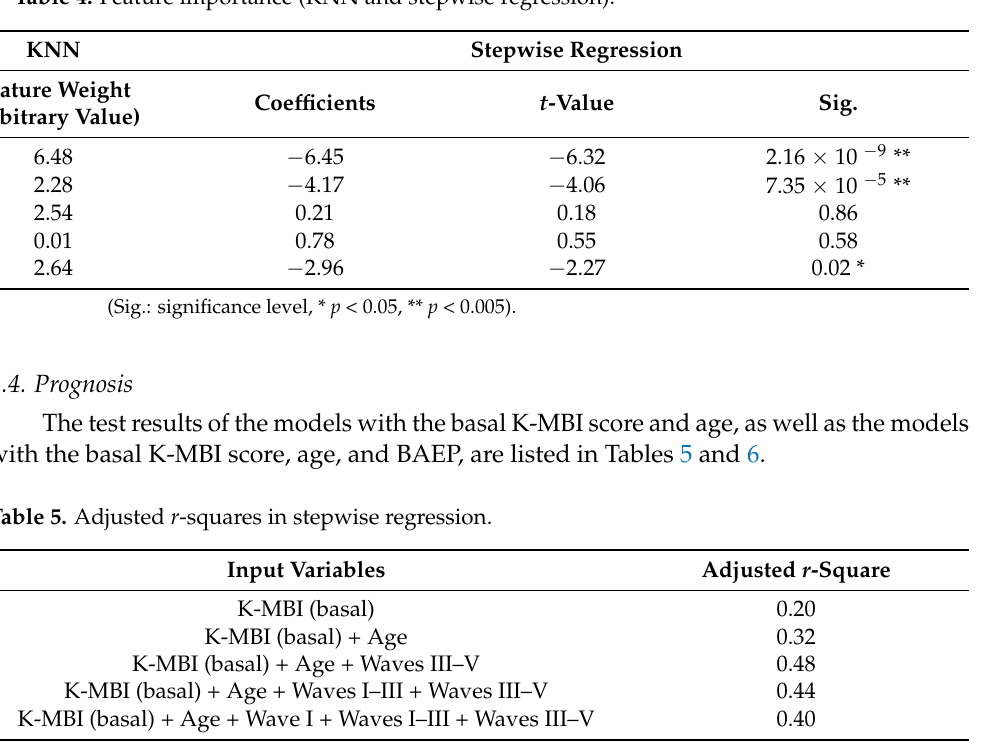
Table 4. Feature importance (KNN and stepwise regression).